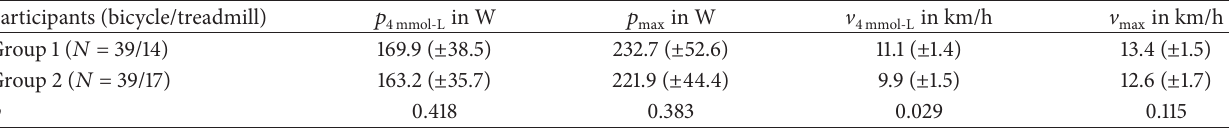
Table 2: Fitness data of military executives who travel frequently and moderately often: a comparison. All data are presented as mean ± standard